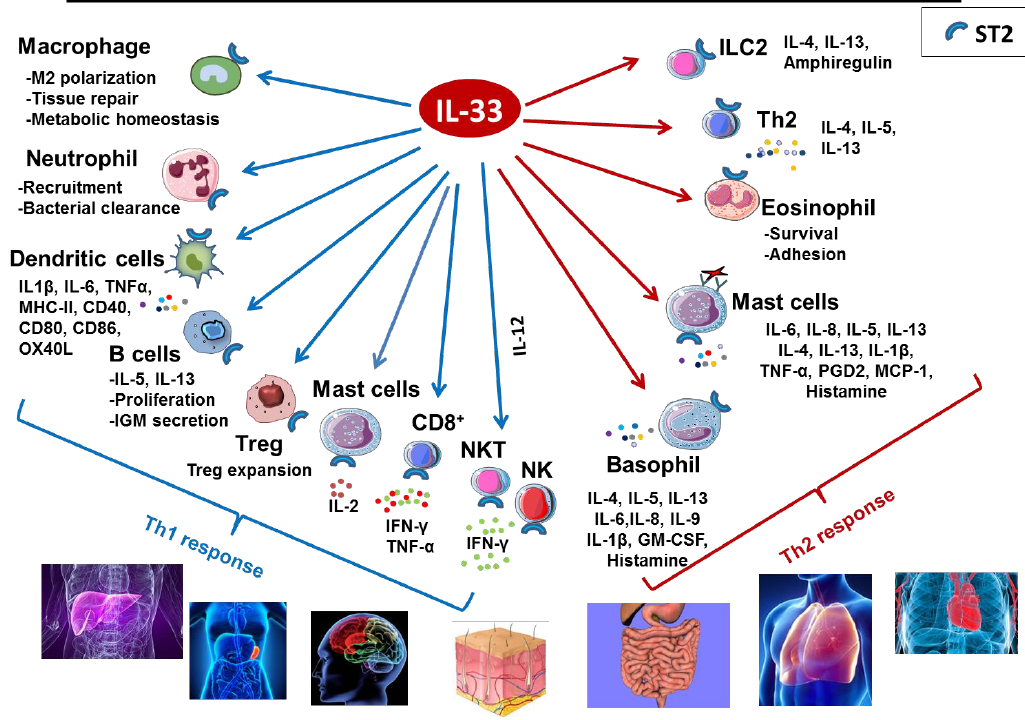
Figure 2. Role of IL-33 in immune response. IL-33 is a potent multi-organ pro-inflammatory cyto- kine acting on cells involved in Th1 orTh2 responses.